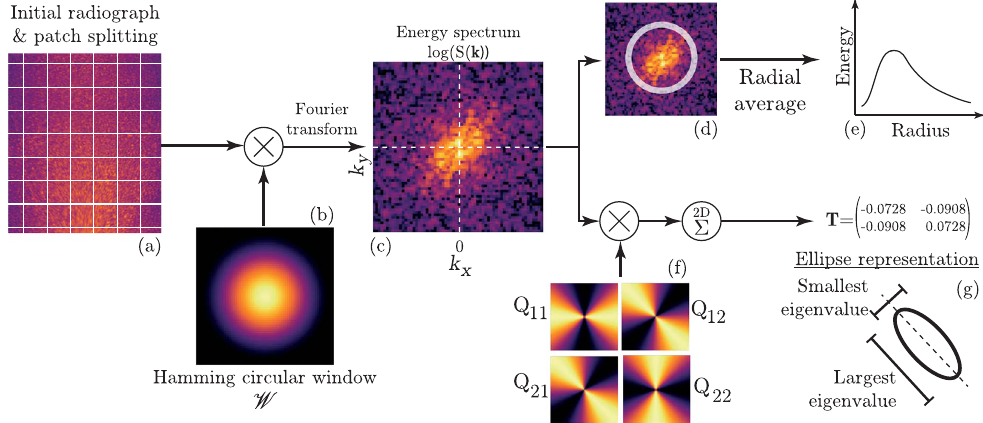
Figure 2. Determination method of fabric properties (particle size and orientation). From left to right: ( a ) patches of 64 × 64 pixels are extracted from a radiograph, ( b ) multiplied by a circular Hamming window, and ( c ) processed by a two-dimensional Fourier transform, leading to the power spectrum of the patch, from which two different processes are applied. Top line: ( d ) the spectrum is summed on circular shells, leading to ( e ) the energy distribution function of the radius. Bottom line: ( f ) the spectrum is multiplied by the orientation matrix Q ( K ) (cf. equation (4)), and summed over all wavevectors k , leading to the symmetric matrix T (cf. equation (5)), that ( g ) can also be represented by an ellipse based on its eigenvalues (ellipse shape) and eigenvectors (ellipse